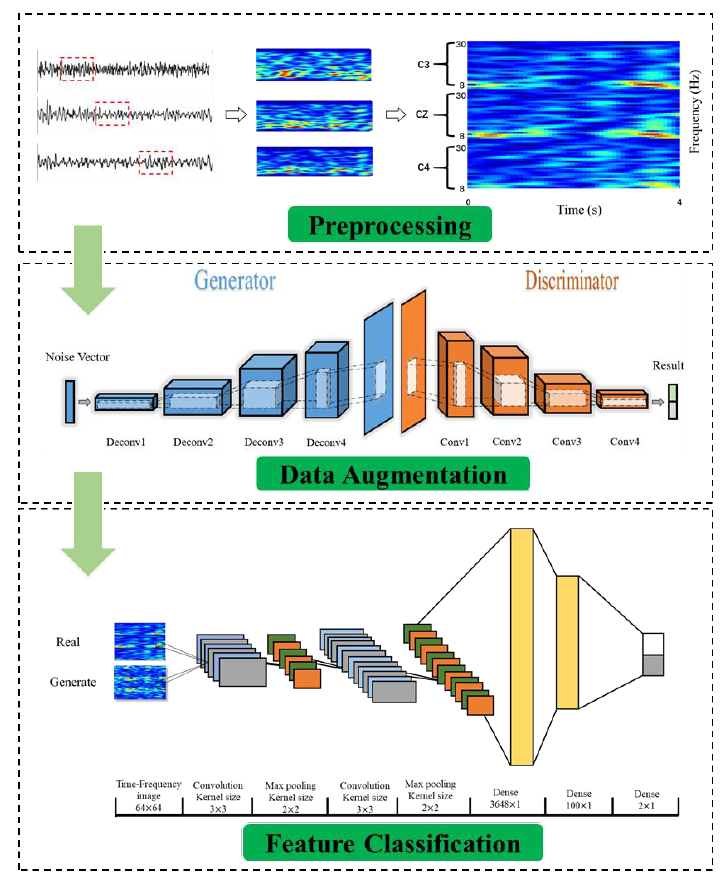
Figure 15. The hybrid network for MI classification.